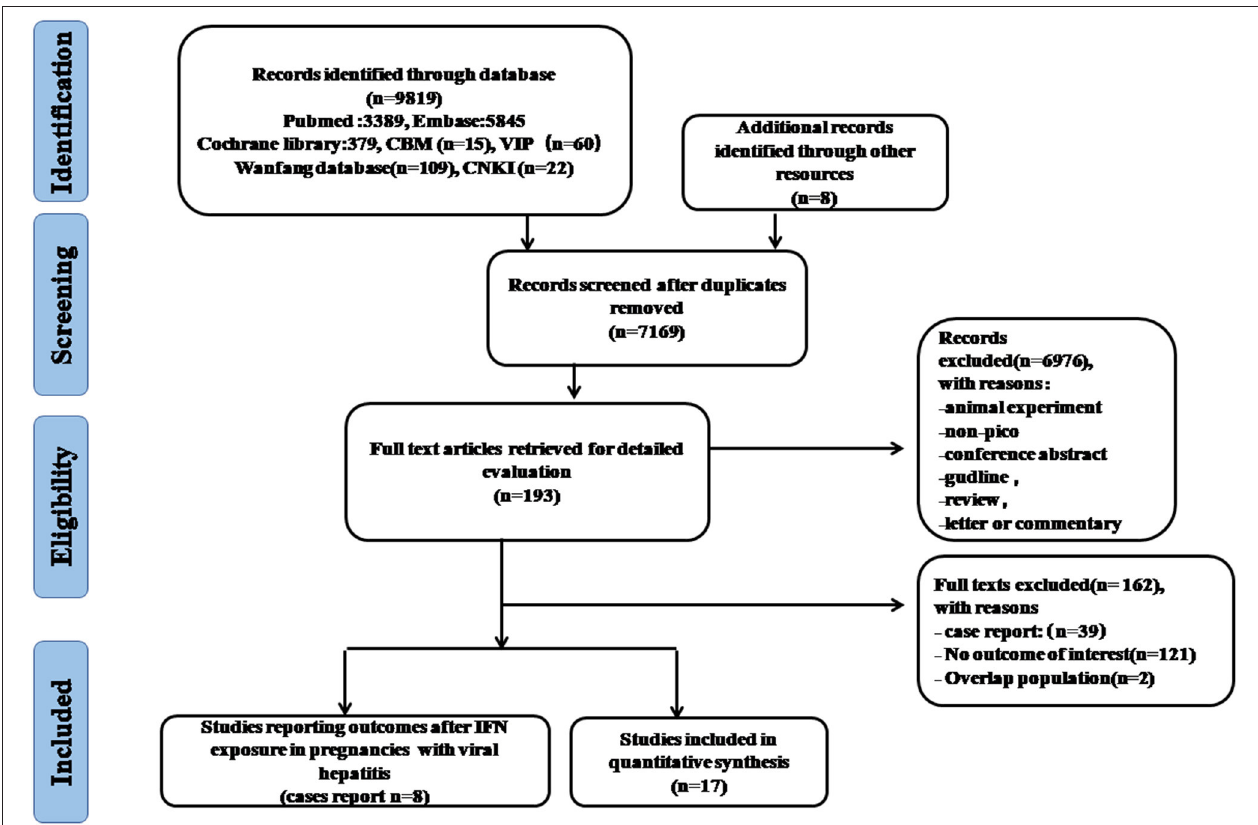
FIGURE 1 | Flowchart of study